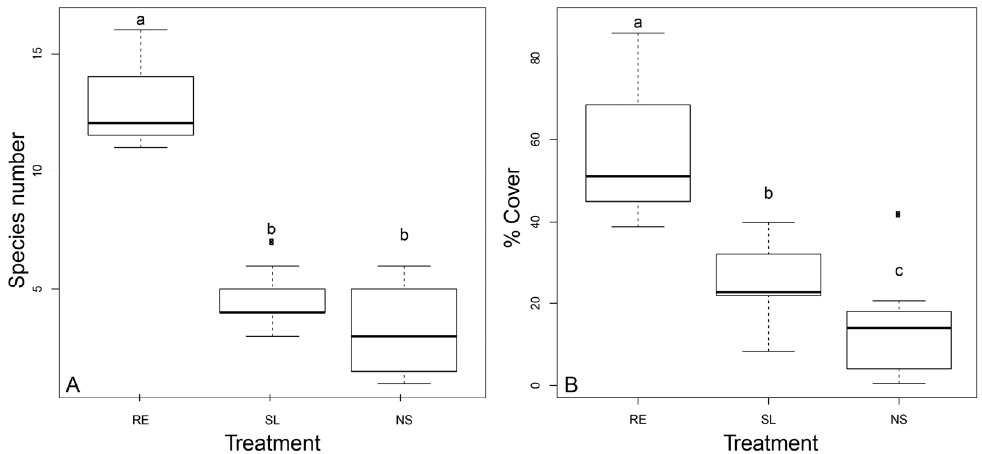
Figure 2. Box plots of species richness ( A ) and abundance (% cover) ( B ) of bryophytes on the three transects. Different superscript letter denote significant differences after post hoc comparisons ( p < 0.001).